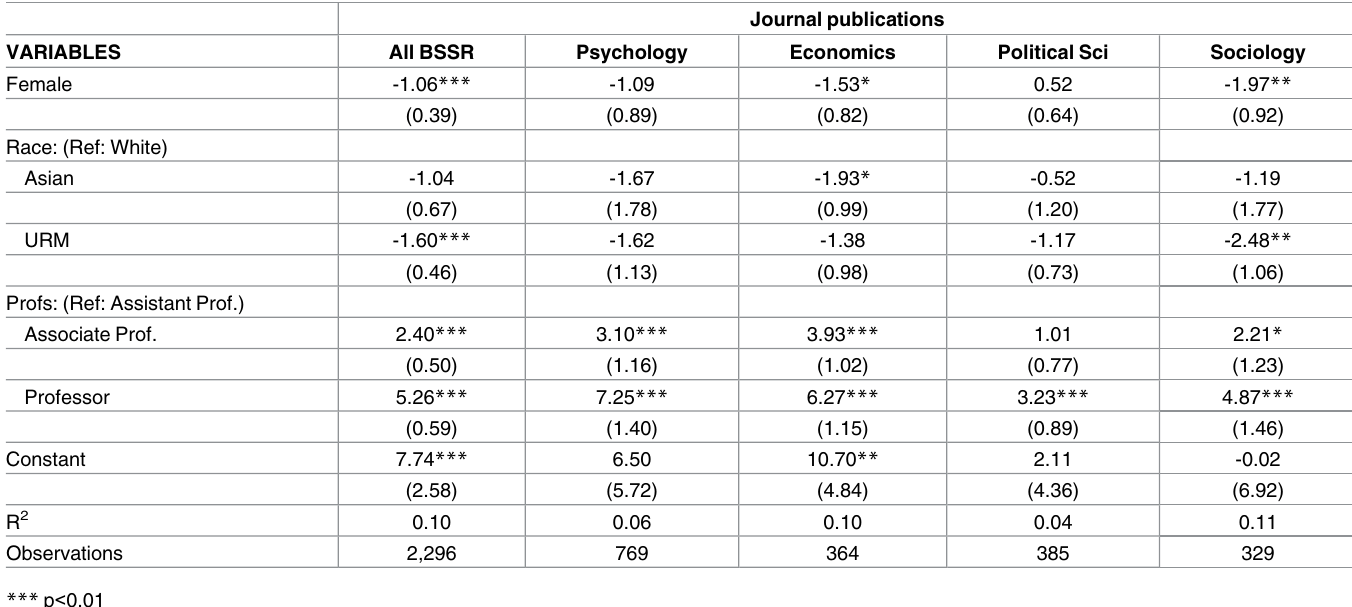
Table 7. Associations between demographic variables and publications among BSSR scientists employed in tenure-track or tenured